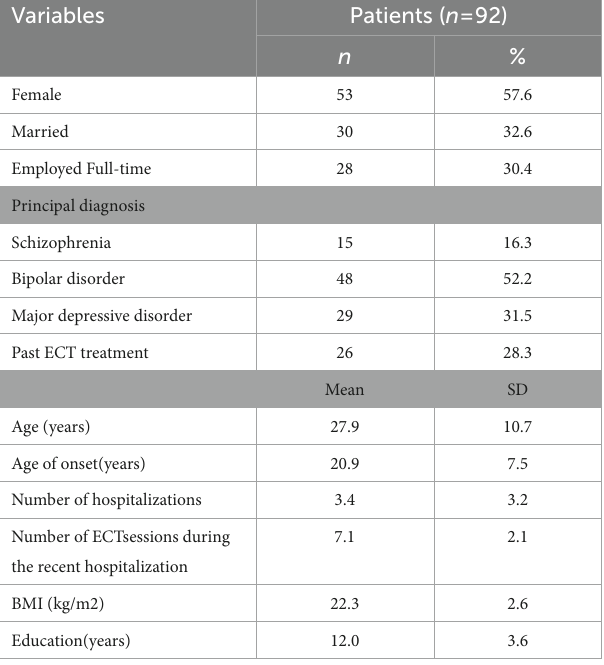
TABLE 1 Basic demographic and clinical characteristics of patients receiving electroconvulsive